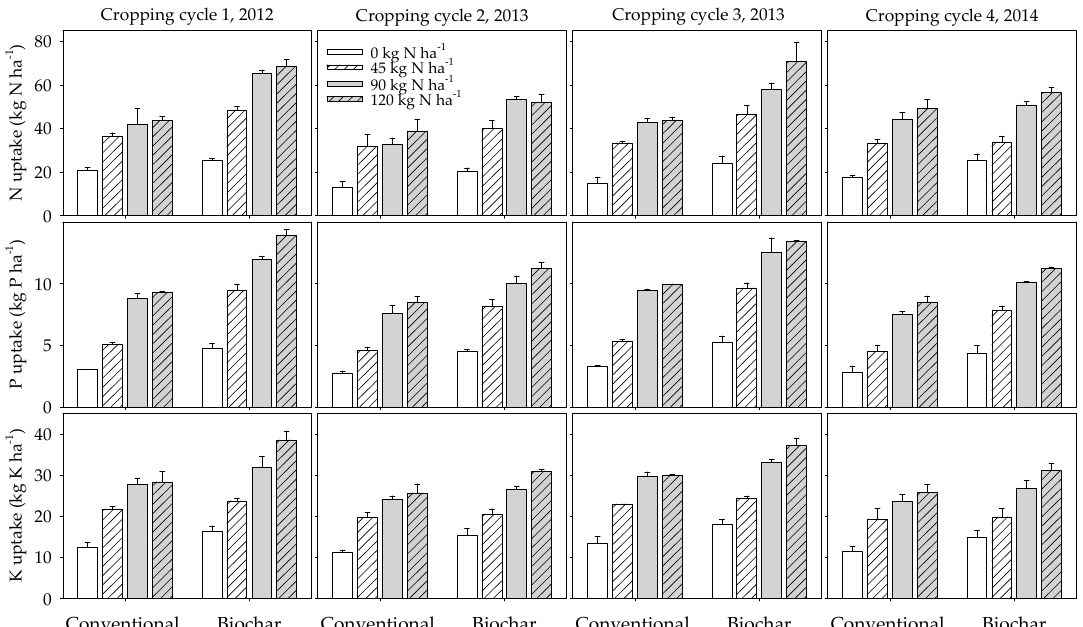
Figure 4. E ff ect of biochar (10 t · ha − 1 ) and nitrogen fertilizer (kg · ha − 1 ) on the nutrient uptake in rice grain under irrigated conditions over 4 cropping cycles, at Kpong, Ghana. Error bars are standard deviations of the means. The 1st and 3rd cropping cycles were from July to November while the 2nd and 4th cropping cycles spanned the period December to April .